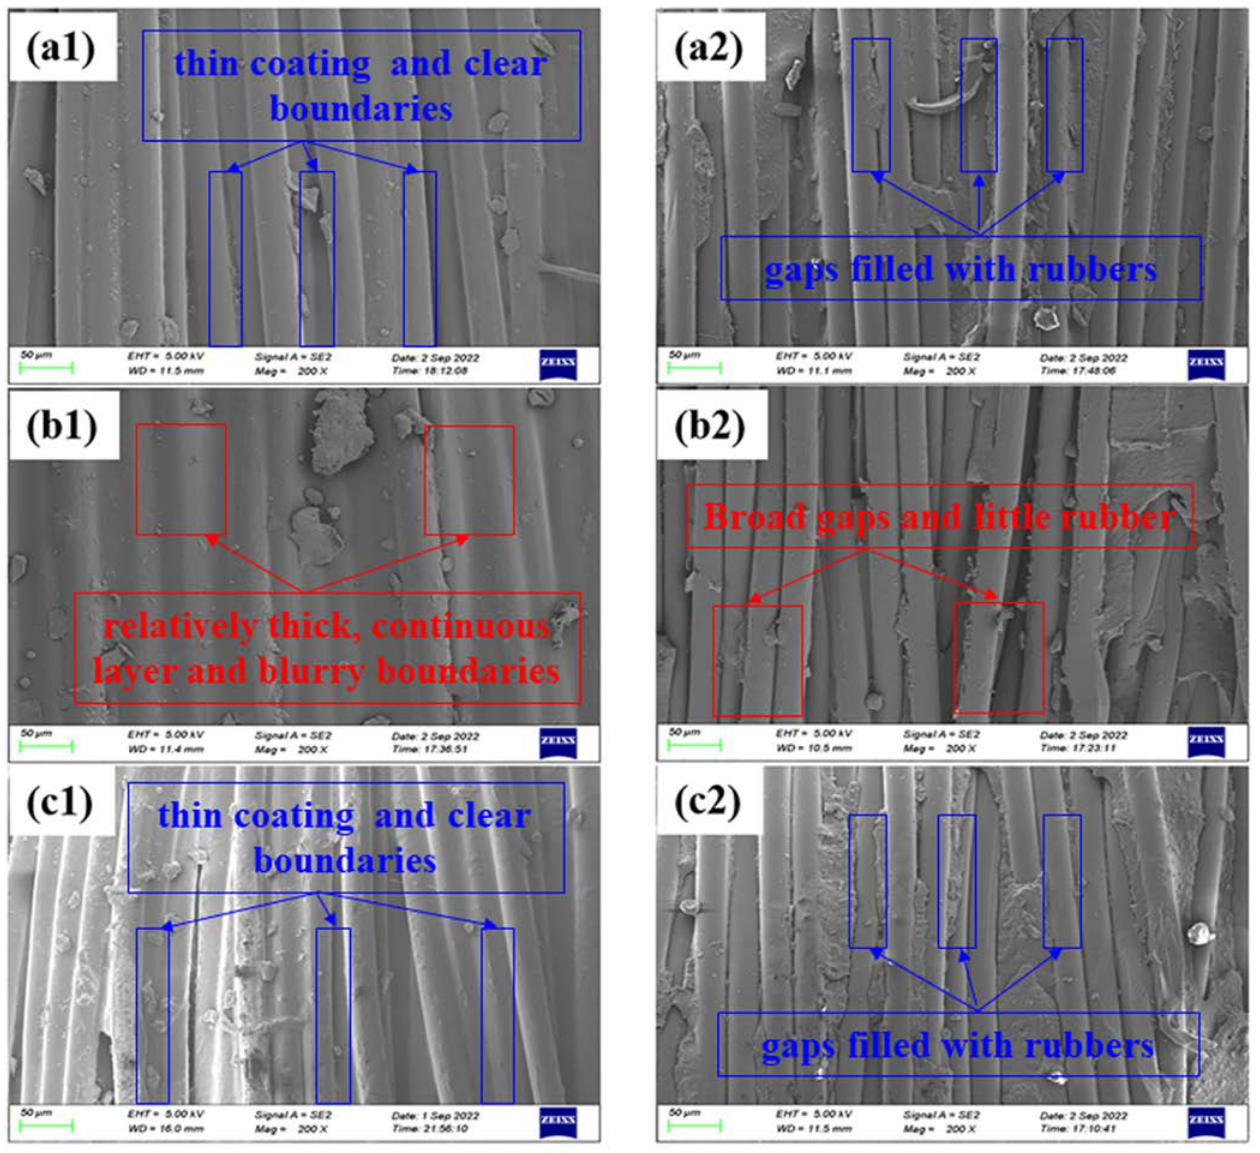
Figure 7. SE M images of the PET fabrics and fabric/rubber composites with different treatments of fabrics: ( a1 – c1 ) PET fabrics impregnated with GTL (PET-GTL), ETL (PET-ETL) and RFL (PET-RFL);